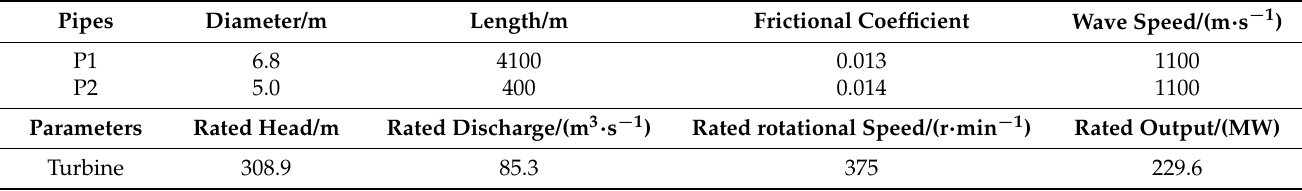
Figure 4. Complete characteristic curves of the turbine: ( a ) 𝑛 1′ − 𝑄 1′ curves. ( b ) 𝑛 1′ − 𝑀 1 ′ curves.